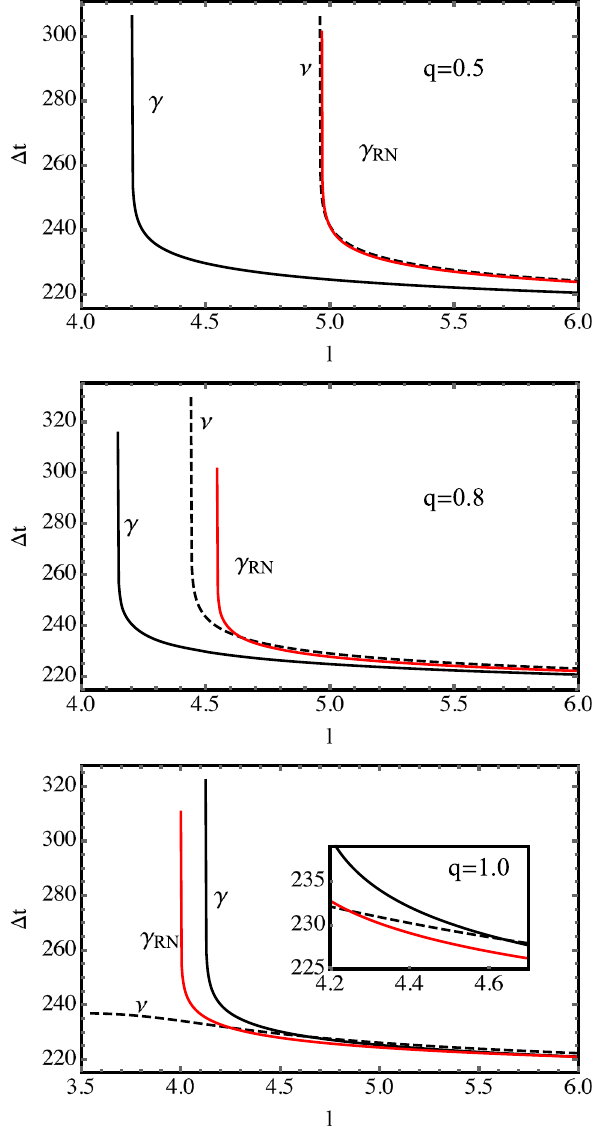
Fig. 6 Three illustrative examples of time delay curves for neutrinos ( ν ), photons-in-Bardeen ( γ ), and photons-in-RN ( γ RN ) as functions of impact parameter l . The plots are constructed for three representative values of magnetic charge parameter q = 0 . 5 (top), 0 . 8, and 1 . 0 (bot-